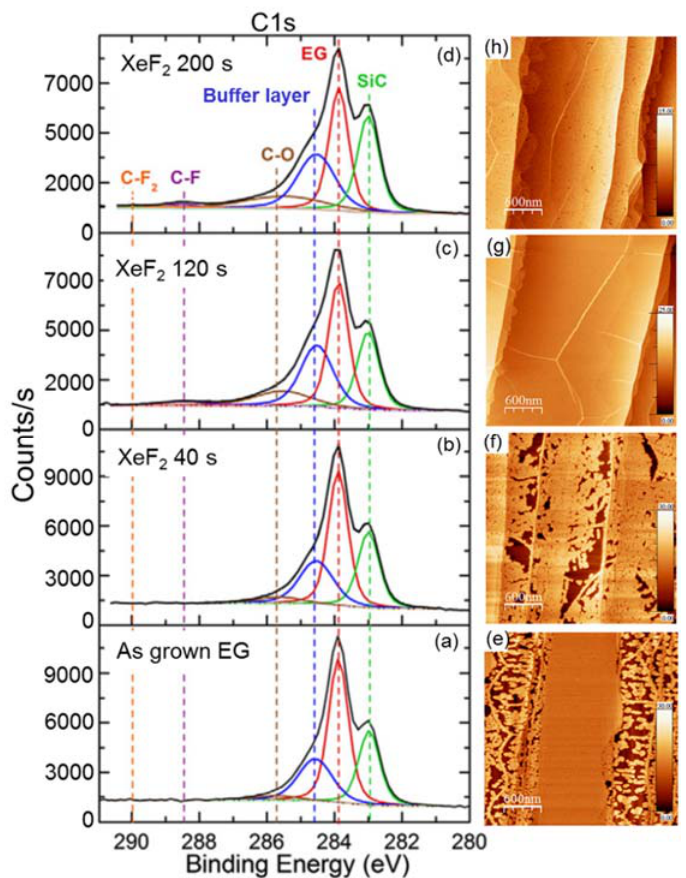
Figure 12. XPS C1s spectra on as-grown EG ( a ) and after XeF 2 exposure for 40 s ( b ), 120 s ( c ) and 200 s ( d ). AFM images of Al 2 O 3 morphology for samples treated with varying amounts of fluorine: ( e ) no pretreatment and ( f ) 40 s XeF 2 exposure results in large areas of no oxide deposition; ( g ) 120 s XeF 2 exposure yields a conformal, uniform film and ( h ) 200 s XeF 2 exposure shows pinholes throughout the oxide. Figures adapted with permission from Ref. [39], Copyright Elsevier